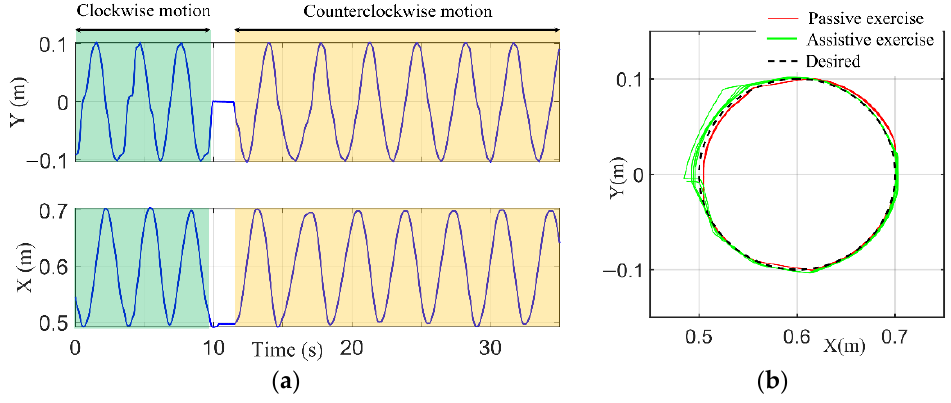
Figure 9. ( a ) Actual trajectory in assistive exercise. ( b ) Trajectory in two exercise modes. The average deviation error L a and the maximum deviation error L m in ( T 1 , T 2 ) are used to evaluate the effectiveness of the DHSS controller.